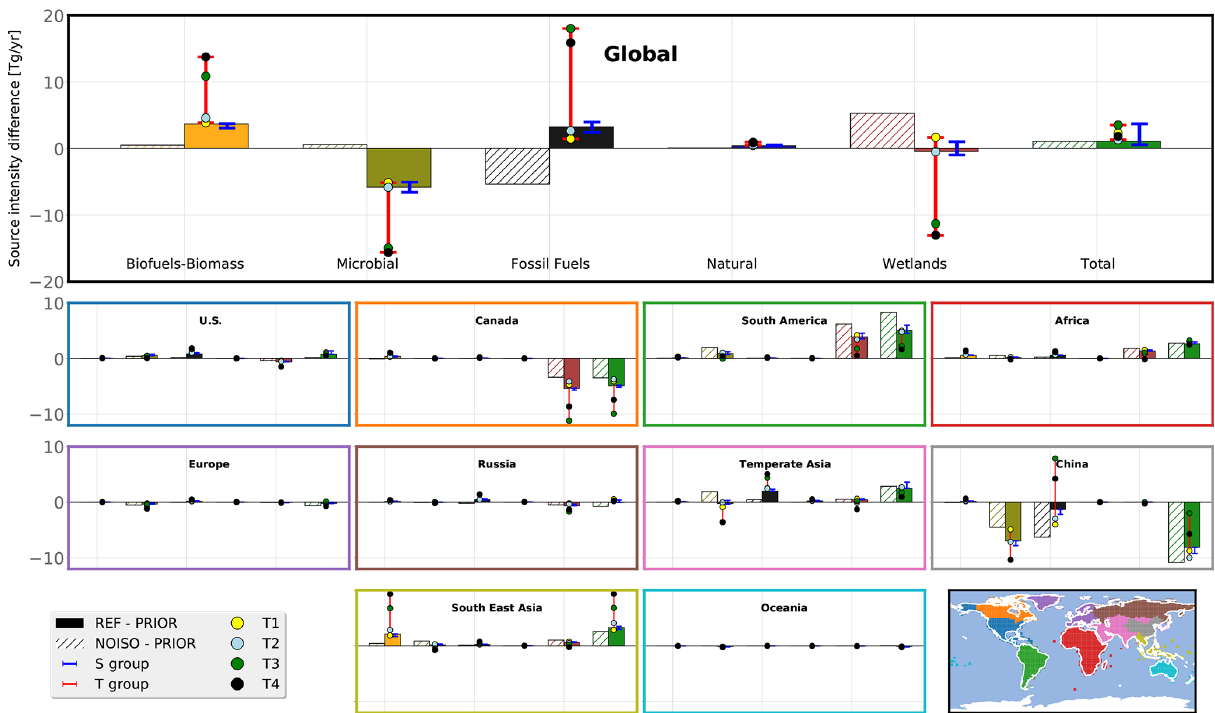
Figure 6. REF and NOISO emission increments for the 2014–2015 period. Prior estimates (PRIOR) are identical for both configurations. The color-filled bars show the differences between REF posterior and prior estimates (REF increment). The hatched bars show the differences between NOISO posterior and prior estimates (NOISO increment). The upper panel refers to the global emissions. The lower panels refer to multiple regions of the globe. The regions are shown on the lower right panel. Red and blue error bars represent the minimum and maximum of the T group and S group, respectively. Circles on the red error bar show the results from the T